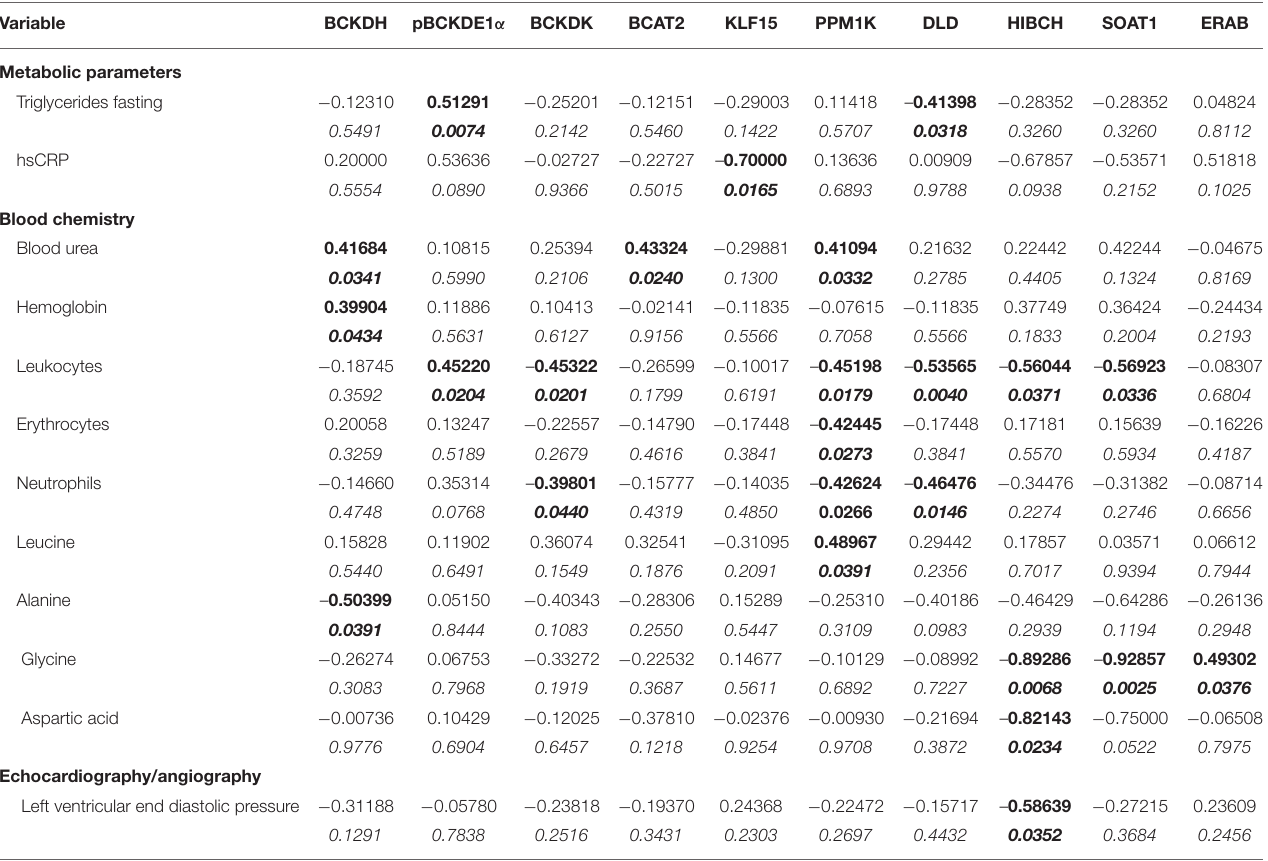
TABLE 4 | Unadjusted Spearman’s correlations for protein expression data of BCAA pathway enzyme in AA from cardiac surgery patients.